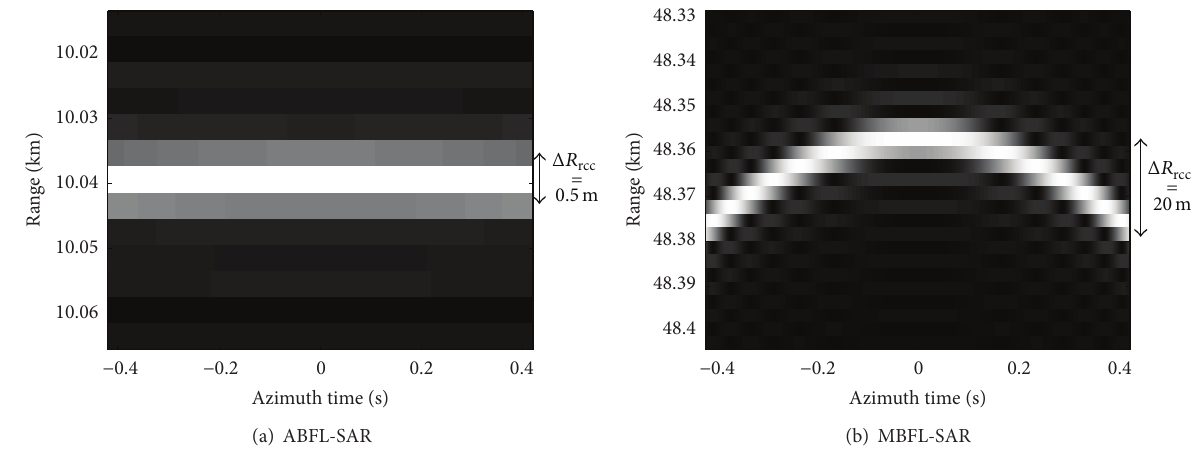
Figure 8: RCC comparison between ABFL-SAR and